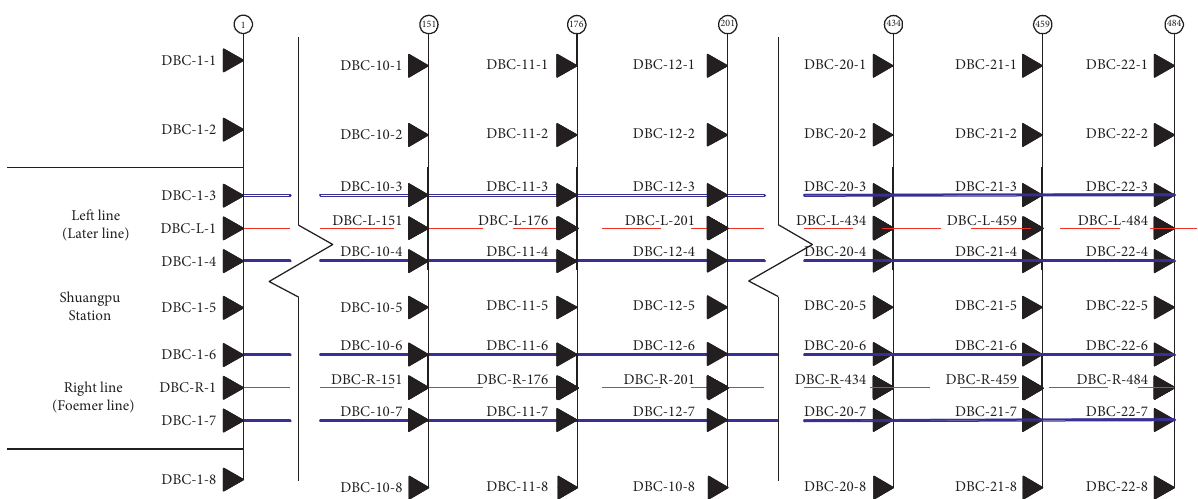
Figure 2: Layout of partial measuring